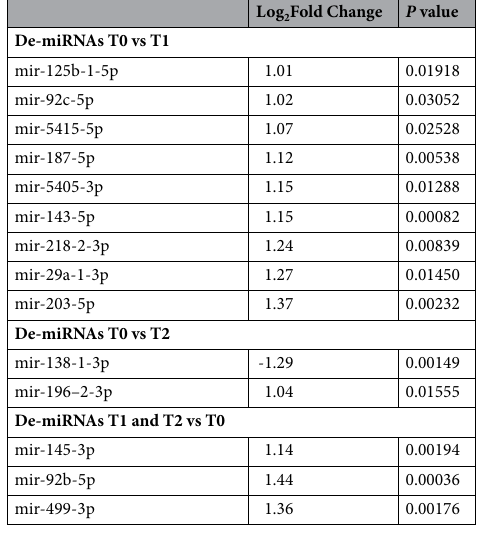
Table 1. Differentially expressed miRNAs. T0 = 24 h pre-surgery; T1 = 2.5 h post-surgery; T2 = 36 h post- surgery.